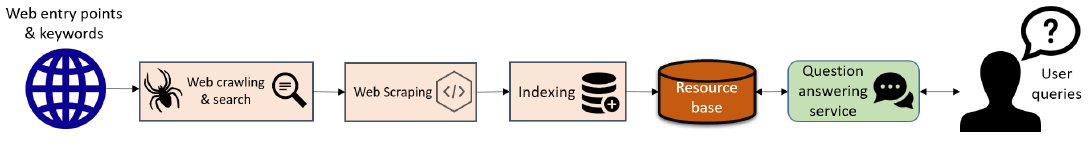
Figure 5. Question answering from web resource framework.